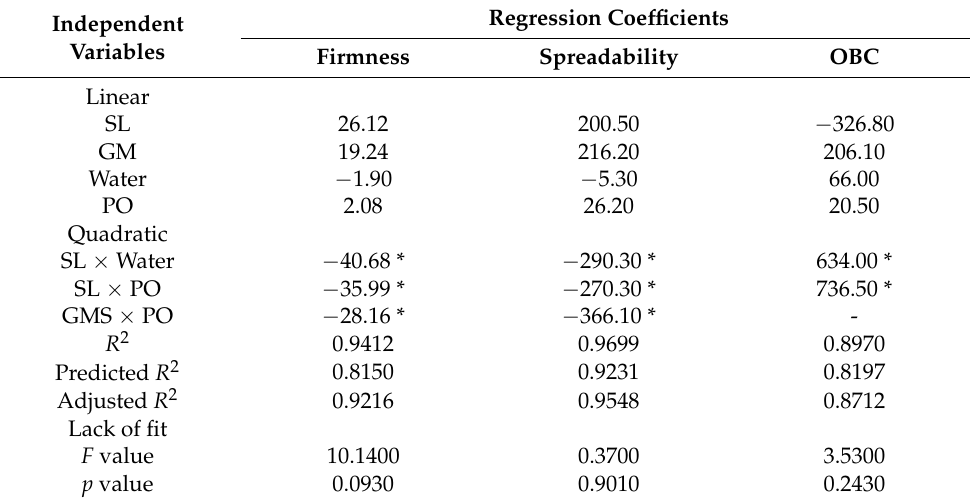
Table 2. Regression coefficients, R 2 , adjusted R 2 , and probabilities for the firmness, spreadability, and oil binding capacity (OBC) of